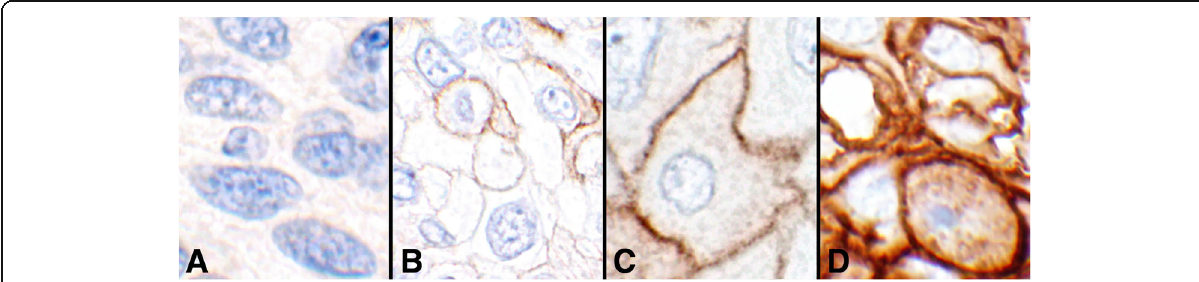
Fig. 1 Intensities of the PD-L1 reactions (objective 60×). a Intensity 0, showing no cell membrane reaction (#8, Table 2). b Intensity 1+, showing weak and/or incomplete circumferential cell membrane reactions (#16, Table 2). c Intensity 2+, showing distinct complete circumferential cell membrane staining (#7, Table 1). d Intensity 3+, showing very strong circumferential cell membrane reaction (#47, Table